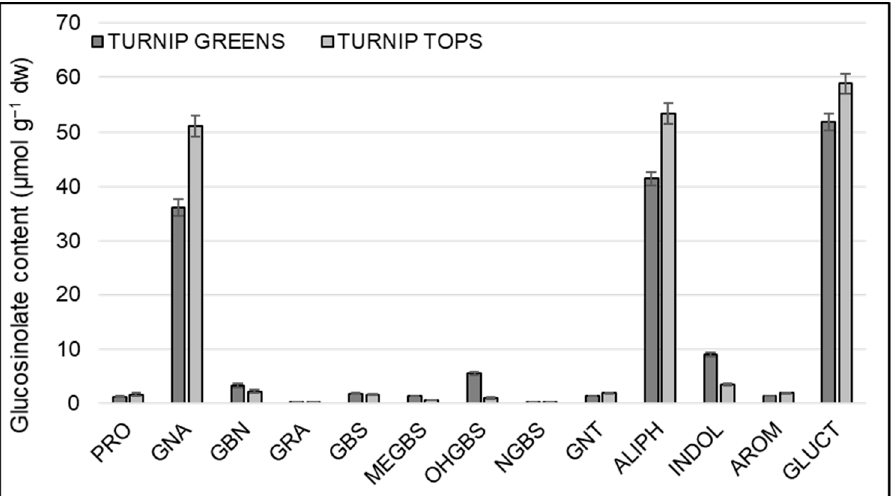
Figure 2 . Total and individual glucosinolate content ( μ mol g − 1 dw) measured in leaves (turnip Figure 2. Total and individual glucosinolate content ( µ mol g − 1 dw) measured in leaves (turnip greens) and flower buds greens) and flower buds (turnip tops) of nine B. rapa varieties grown at two locations from Spain (turnip tops) of nine B. rapa varieties grown at two locations from Spain in 2017–2018 growing in 2017–2018 growing season.